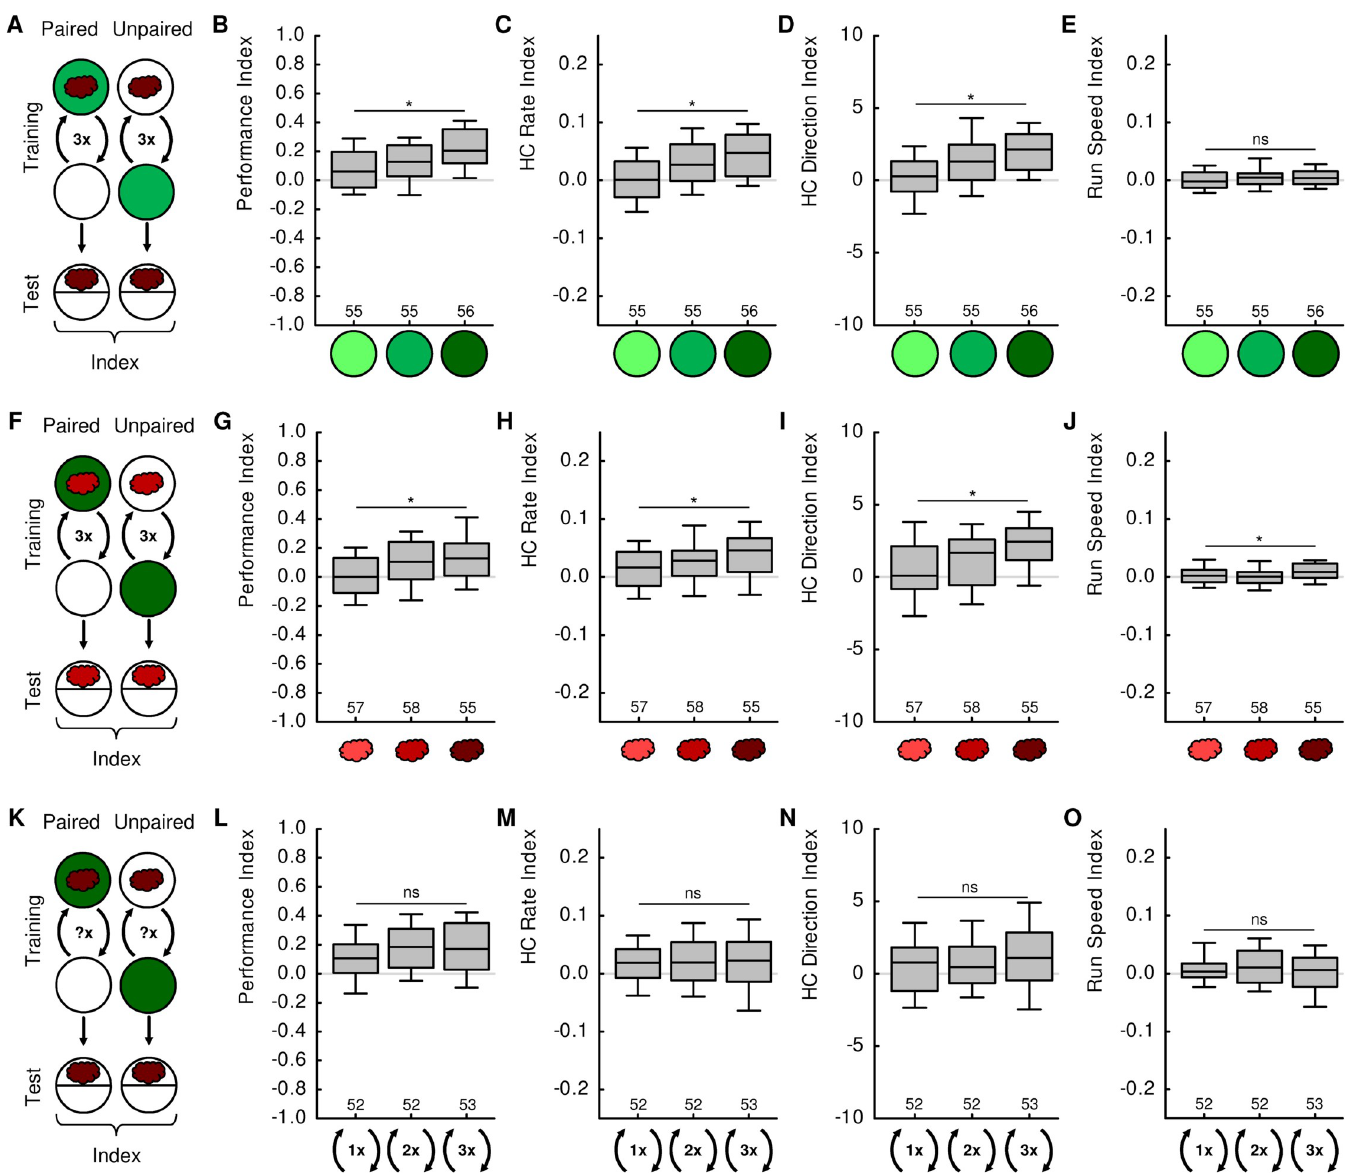
Fig 1. Parametric modulations of learned microbehaviour. (A) Groups of larvae were trained with either paired or unpaired presentations of n -amyl acetate (AM) as odour (red cloud) and fructose (FRU) as reward (green filled circles). Three training cycles were performed with an AM dilution of 1:20. The FRU concentrations used were 0.2, 0.6 and 2 mol/L, indicated by light, medium or dark green fillings in B-E, respectively. (B-D) Increasing FRU concentrations lead to increasing values of (B) the Performance Index (KW: H = 21.0, df = 2, p < 0.0001), (C) the HC Rate Index (KW: H = 21.6, df = 2, p < 0.0001), and (D) the HC Direction Index (KW: H = 23.9, df = 2, p < 0.0001). This indicates that higher FRU concentrations support stronger memories and lead to stronger modulations of both HC rate and HC direction. (E) FRU concentration had no significant effect on run speed modulation (KW: H = 1.5, p = 0.47). (F) As in A, except that a fixed FRU concentration of 2 mol/L was used, and AM dilutions were varied to be 1:2000, 1:200 or 1:20, indicated by light, medium or dark red clouds in G-J, respectively. (G-J) Increasing AM concentrations lead to increasing values of (G) the Performance Index (KW: H = 15.7, df = 2, p = 0.0004), (H) the HC Rate Index (KW: H = 8.8, df = 2, p = 0.012), (I) the HC Direction Index (KW: H = 15.7, df = 2, p = 0.0004), and (J) the Run Speed Index (KW: H = 7.9, df = 2, p = 0.020). (K) As in A, except that a fixed FRU concentration of 2 mol/L was used. 1, 2 or 3 training cycles were performed. (L-O) The number of training cycles did not significantly affect (L) the Performance Index (KW: H = 4.6, df = 2, p = 0.10), (M) the HC Rate Index (KW: H = 0.2, df = 2, p = 0.92), (N) the HC Direction Index (KW: H = 1.8, df = 2, p = 0.40), or (O) the Run Speed Index (KW: H = 0.9, p = 0.64). Thus, the memory strength was not significantly determined by training cycle number; nor were the HC rate, HC direction or run speed. Asterisks or “ns” indicate significant or non-significant Kruskal-Wallis tests, respectively. Sample sizes are indicated below each box plot. Box plots represent the median as the middle line and 25% / 75% and 10% / 90% as box boundaries and whiskers, respectively. Outliers are not displayed. The values for preference, HC rate-modulation, Reorientation per HC, and Run speed-modulation after paired and unpaired training that underlie this figure are displayed in S1–S3 Figs. For the underlying source data, see S1 Dataset.